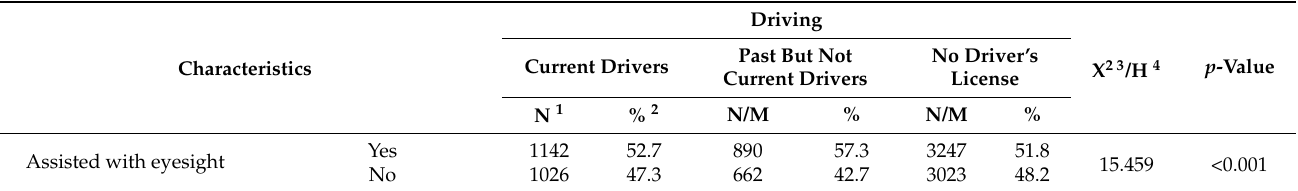
Table 3. Physical function and daily life